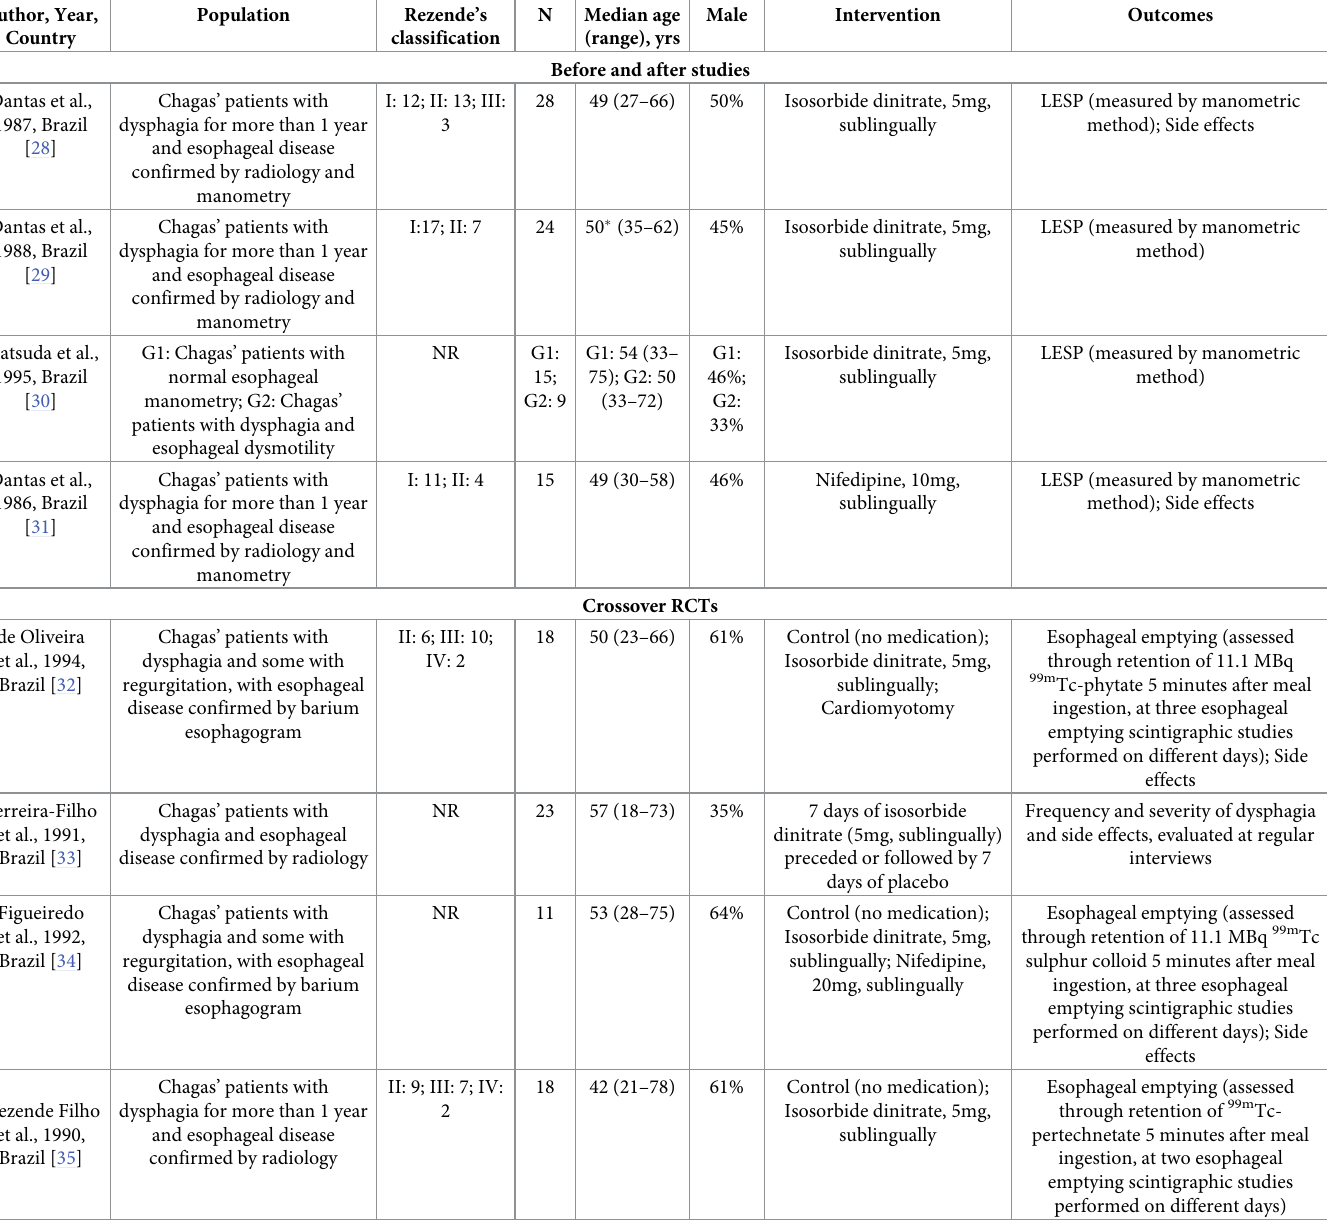
Table 2. Characteristics of studies included in the systematic